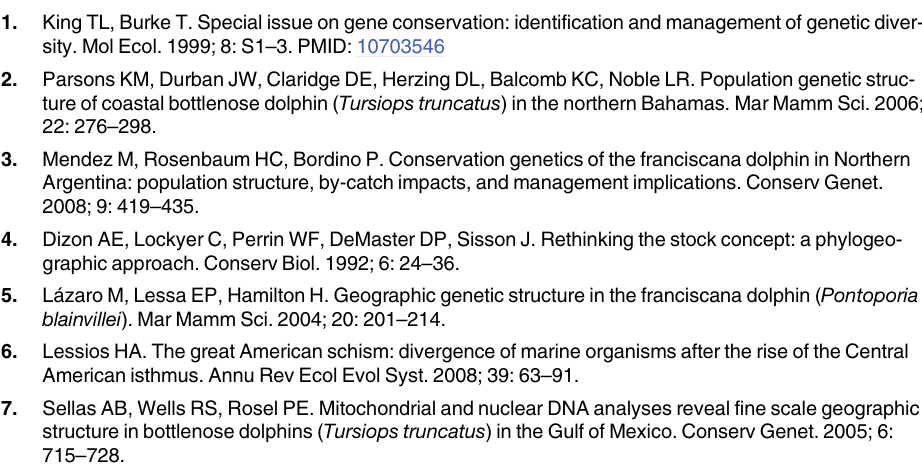
S1 Fig. Genetic isolation by distance. Results of the Mantel test for correlation between the genetic distance [F /(1-F )] and the logarithm (Log) of geographic distance between sam- ST ST pling sites. S1 Table. Frequency of occurrence and sampling sites of the mtDNA control region haplo- types. Asterisks show the novel haplotypes found in this study. Dashes indicate unknown fre- quency. AA and AB: haplotypes with unknown exact sampling site and/or frequency, collected from Argentina [3,30] and Brazil [34], respectively. RJ: Rio de Janeiro; RG: Rio Grande do Sul; UY: Uruguay; SCL: San Clemente del Tuyú; PN: Pinamar; NC: Necochea; CL: Claromecó; MH: Monte Hermoso; BB: Bahía Blanca; RN: Río Negro. S2 Table. Gene flow between localities. Estimates of migration rates, time since divergence and θ between locations. NC: Necochea; CL: Claromecó; MH: Monte Hermoso; RN: Río